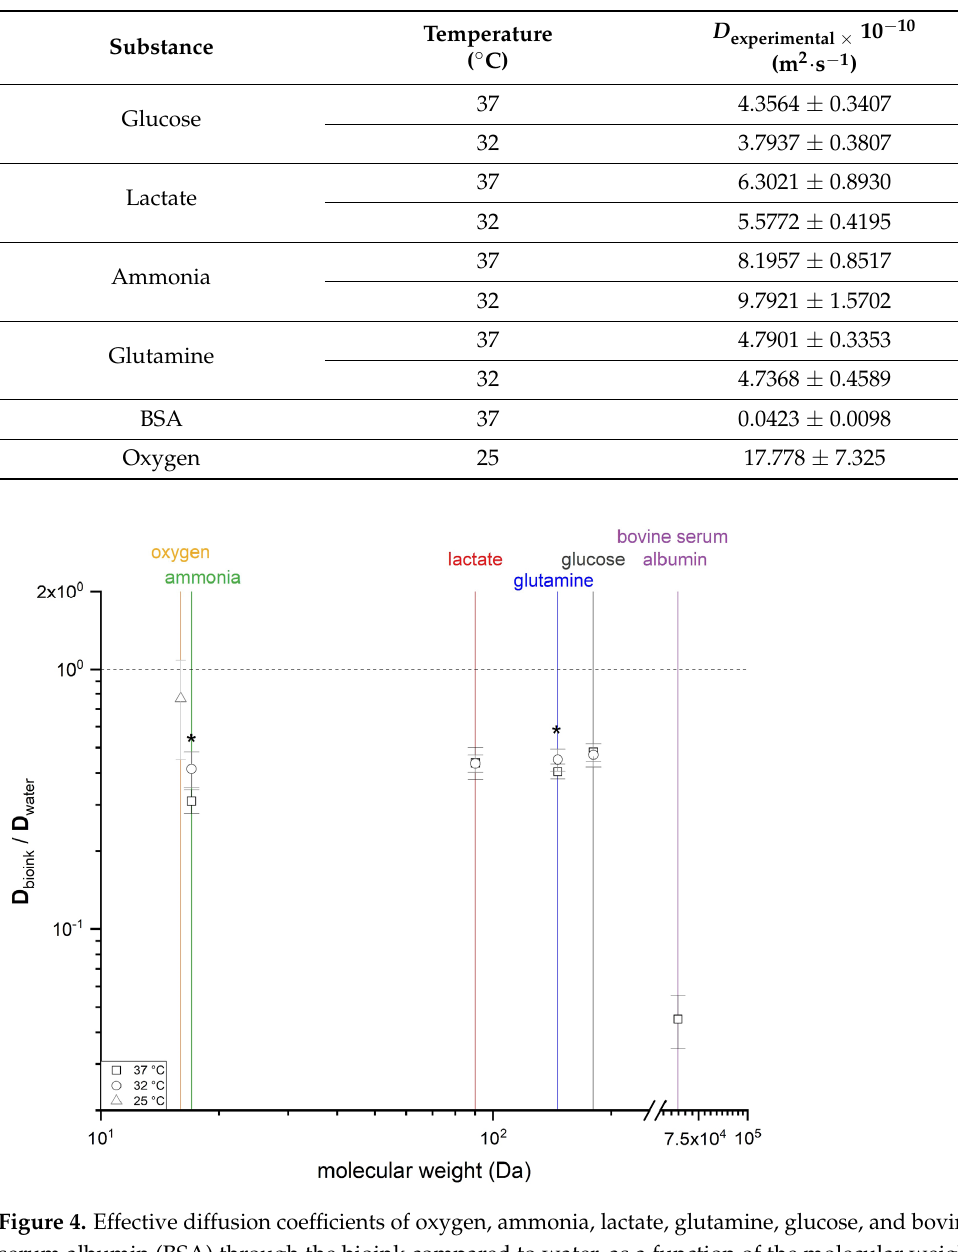
Table 2. Diffusion coefficients calculated for essential nutrients, their metabolites, and the model protein bovine serum albumin (BSA) migrating through bioink (data from Figure 3). Data are mean values ± SD at two different temperatures. Each experiment involved n = 10 Franz diffusion cells, or n = 4 repeats in an Ussing chamber in the case of oxygen diffusion.